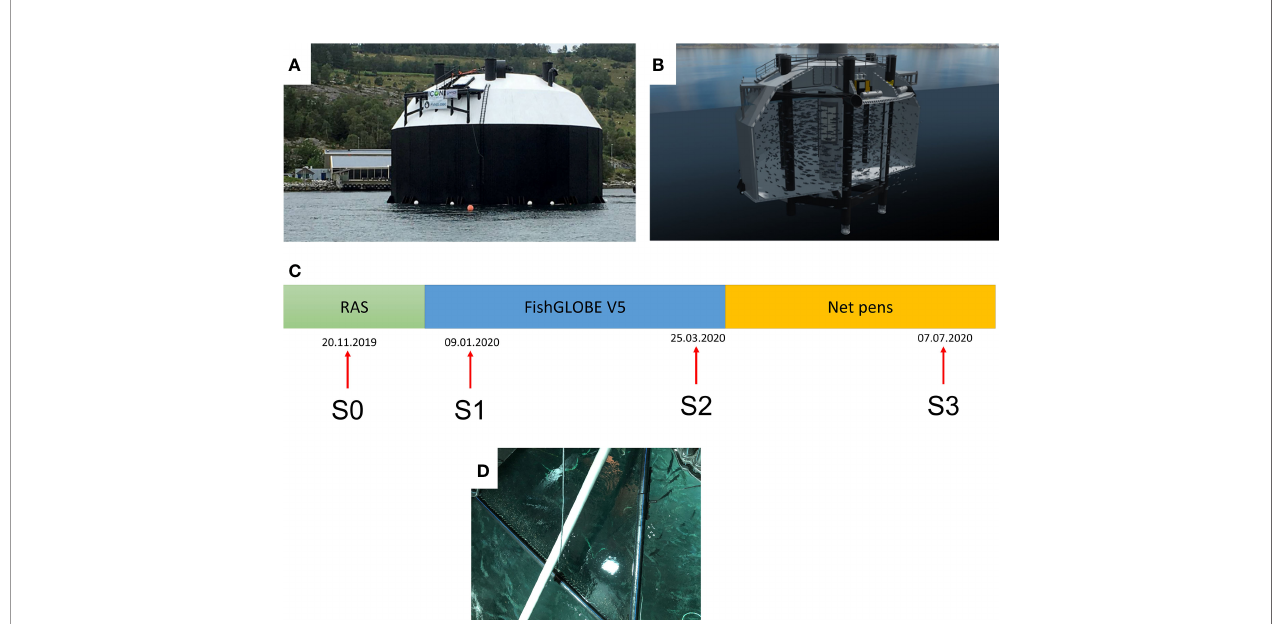
FIGURE 1 | FishGLOBE V5 and summary of monitoring programme employed in the current study. (A) Exterior photo of a FishGLOBE V5 system and (B) diagrammatic representation of the interior, showing the upper deck and the compartment for fi sh rearing. (C) The monitoring programme of the group of salmon followed 3 main phases – Phase I was the RAS phase, followed by Phase II, where fi sh were transferred to FishGLOBE V5 and reared for 3 months, and then eventually moved to net pens. There were 4 main sampling points (S), which happened when fi sh were in the FishGLOBE V5 system. Dates are given as day.month.year. (D) A photo illustrating how fi sh were taken from the FishGLOBE V5 during sampling. (A) Photo: ©FishGLOBE; (B) Illustration: ©FishGLOBE; (C) Photo: Kevin